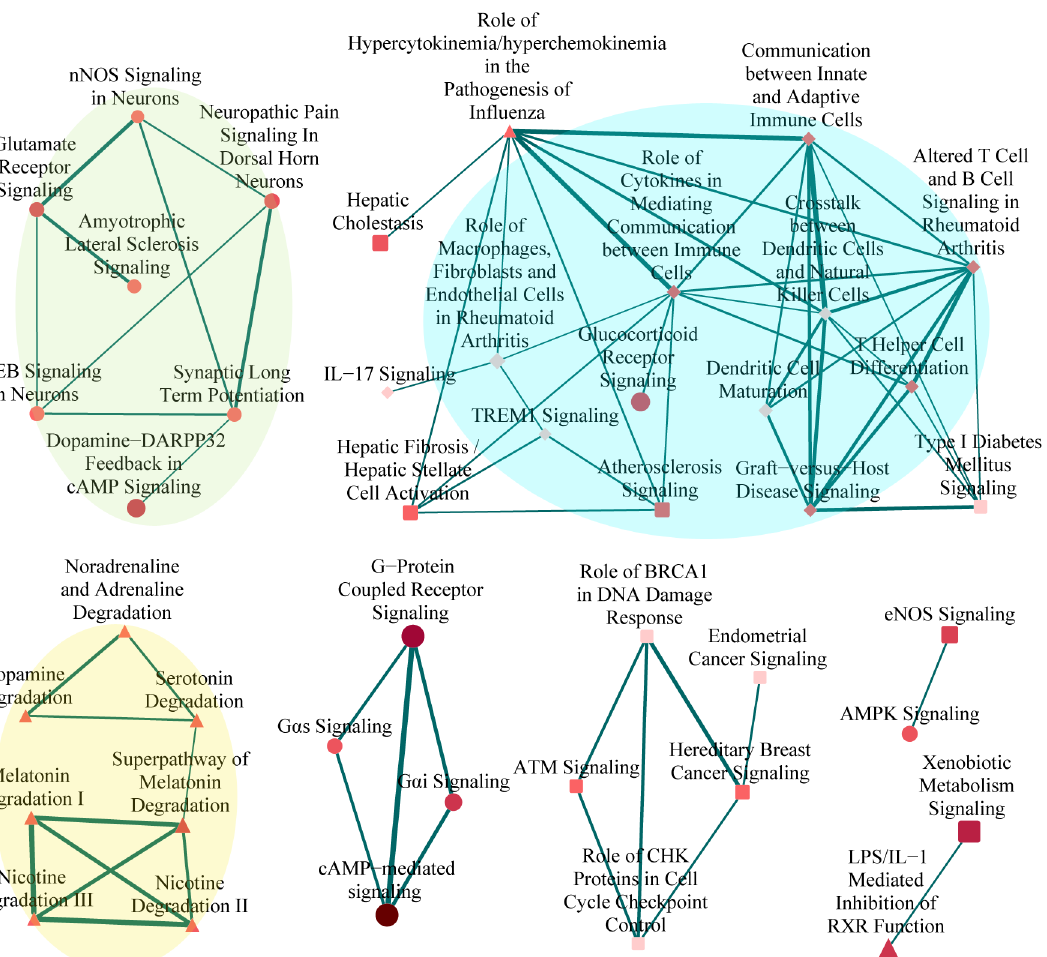
Fig 1. Pathway crosstalk among NAGenes-enriched pathways. Nodes represent pathways and edges represent crosstalk between pathways. Node size corresponds to the number of NAGenes found in the corresponding pathway. Node color corresponds to the P BH -value of the corresponding pathway. Darker color indicates lower P BH -value. Edge width corresponds to the score of the related pathways. Node shape indicates pathway categories, with ellipse for neurodevelopment, diamond for immune, triangle for metabolism, square for other pathways.